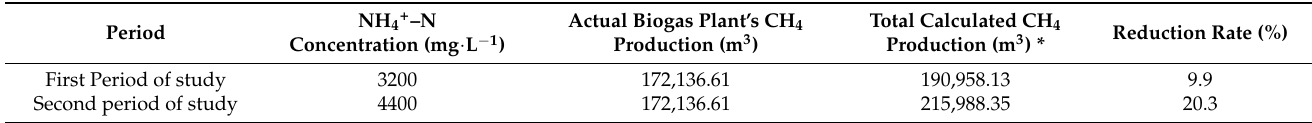
*: Values from Table 2. Calculated from the sum of CH 4 potential of each substrate multiplied with the added quantity of each substrate in the reactor for each study period. The Volatile Fatty Acids (VFAs) concentrations act as a good indicator of process imbalance in anaerobic digestion [32,33]. The VFAs concentrations of the biogas plant effluent samples from the two periods are presented in Table 4. In the 1st study period, all the VFAs concentrations where lower than those of the 2nd period, thus revealing a toxicity effect but as not as strong as it was in the 2nd period. The acetic and propionic acid concentrations during the 2nd period of examination were very high, revealing the presence of toxicity in the anaerobic reactor of the biogas plant. It was reported that the increased concentration of acetic acid is associated to the absence or restricted growth of aceticlastic methanogens, which was probably due to high concentrations of ammonia [10]. Furthermore, Wang et al. reported that when the concentration of propionic acid exceeded the threshold of 900 mg · L − 1 , the bacteria concentration was decreased with detrimental effects on their activity [34]. Inhibition of methanogens growth was observed